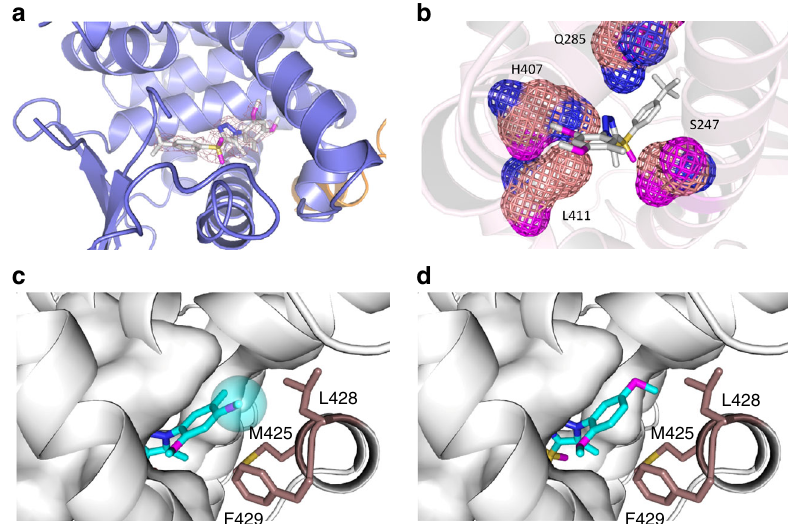
Fig. 5 Crystal structure of the hPXR LBD in complex with SJB7 and the SRC-1 coactivator peptide. a 2Fo-Fc map (1.0 sigma) around SJB7. The hPXR LBD is depicted in blue and SRC-1 in orange . b SJB7 is fi xed in a tunnel created by S247, Q285, H407 and L411 (shown as meshes ). c SJB7 interacting with the AF-2 helix residues M425, L428 and F429. The sphere indicates the methoxy group that contacts the L428 and F429 pair. d The antagonist SPA70 docked in the ligand-binding site, showing the missing interactions with L428 and F429. Color code for the stick representations: blue , nitrogen; magenta , oxygen; yellow , sulfur Table 1 Data collection and re fi nement